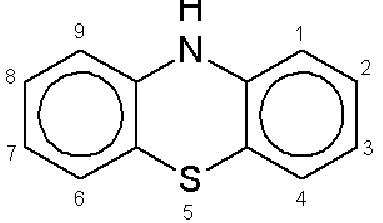
Figure 1 . Fundamental structure of phenothiazines. Figure 1. Fundamental structure of